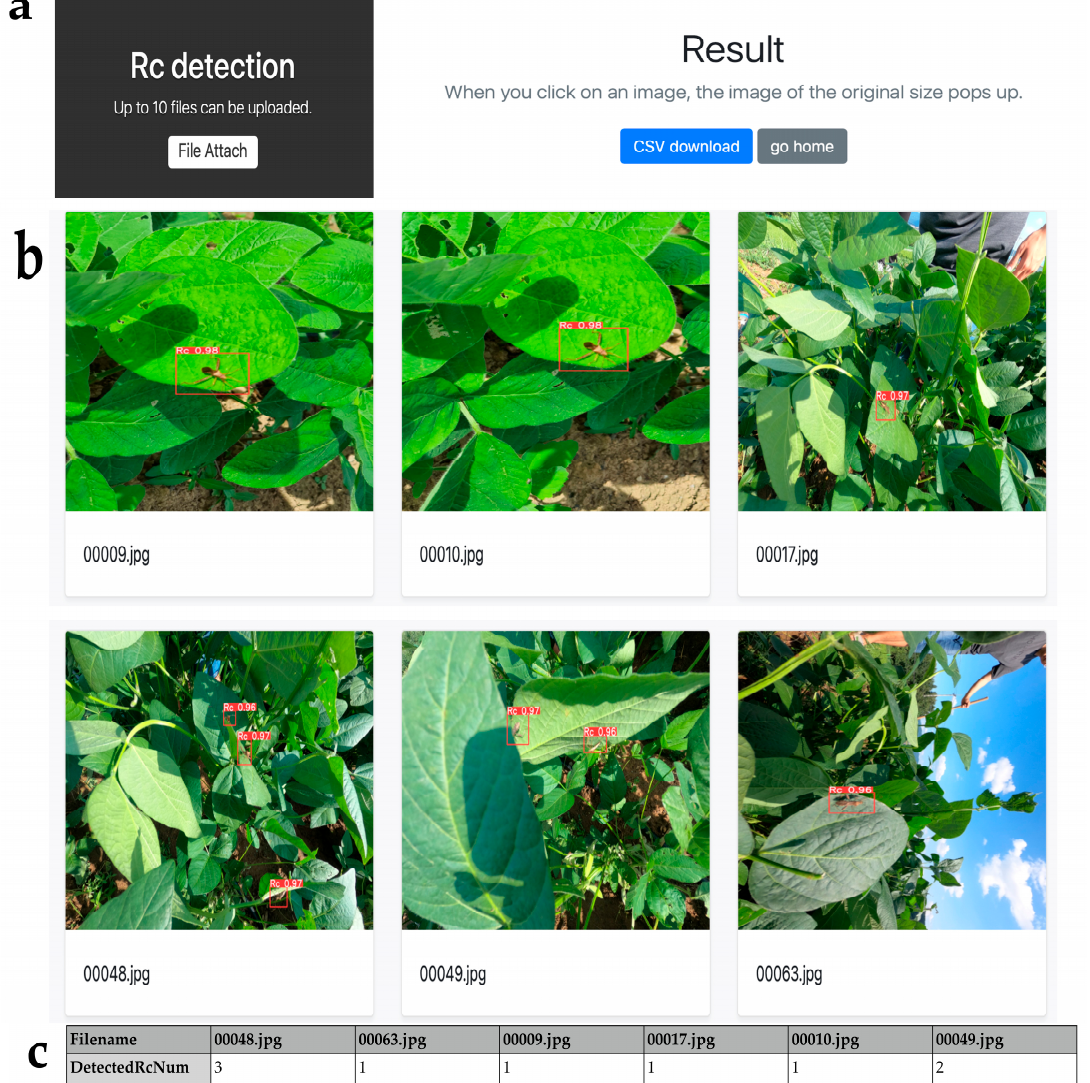
Figure 10. R. pedestris detection in web application tools. ( a ) The web app’s main screen; ( b ) the result screen that appears after detection is completed; ( c ) the number of detected boxes in each photo is marked and sent to the provided portable device as a CSV file.